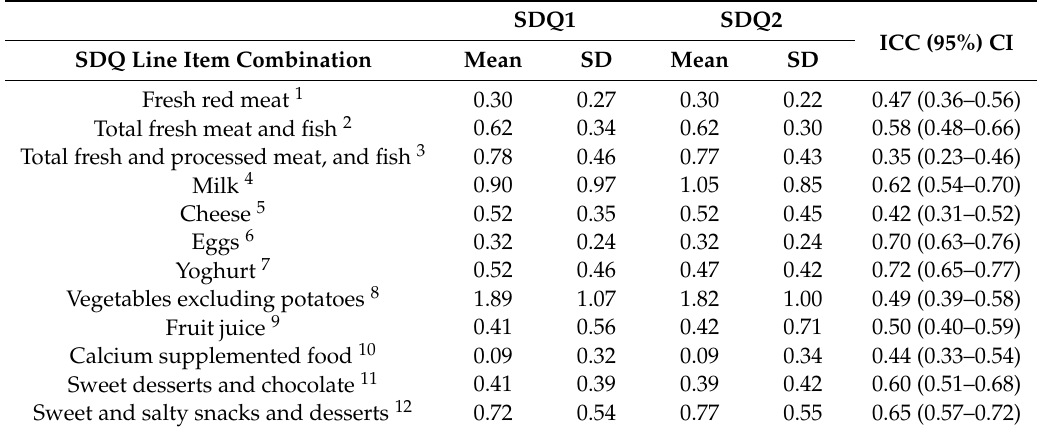
Table 3. Estimated intakes of line items and combinations of line items from SDQ1 and SDQ2 and test-retest reliability between administrations, CLSA Diet Study ( n =